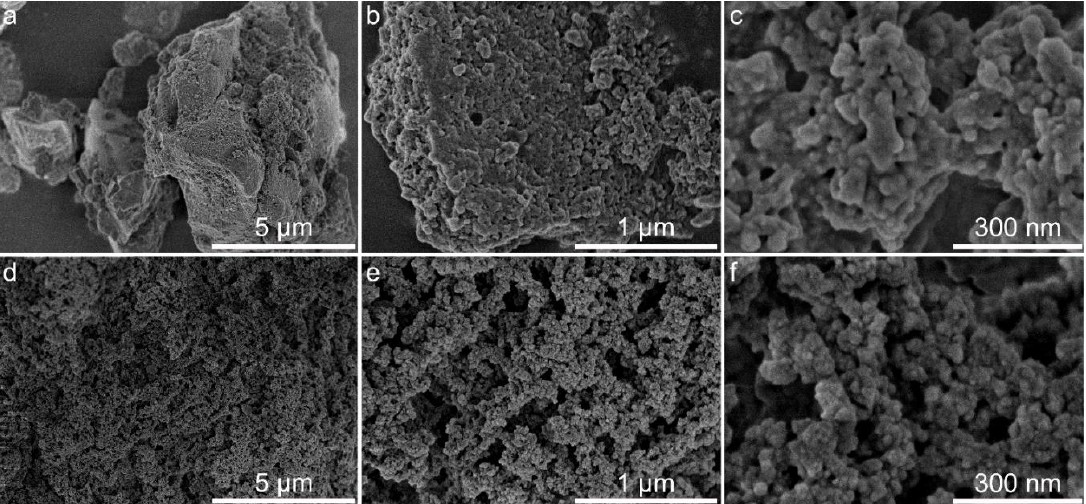
Figure 7. SEM images of the original CleanFlowBlack lignin ( a – c ) and the CleanFlowBlack lignin – silica hybrid ( d – f ) (high-resolution topographic contrast secondary electron imaging, parameters: accelerating voltage = 1 kV; working distance: ( a – c ) 1.4 mm, ( d – f ) 1.7 mm; magnification: ( a , d ) ×10,000, ( b , e ) ×50,000, ( c , f ) ×150,000).